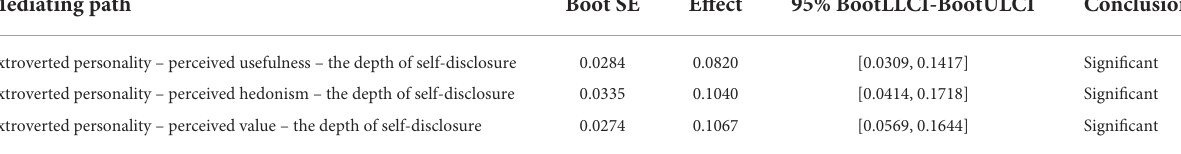
TABLE 10 Test of mediating effect (taking introverted personality as the control group for